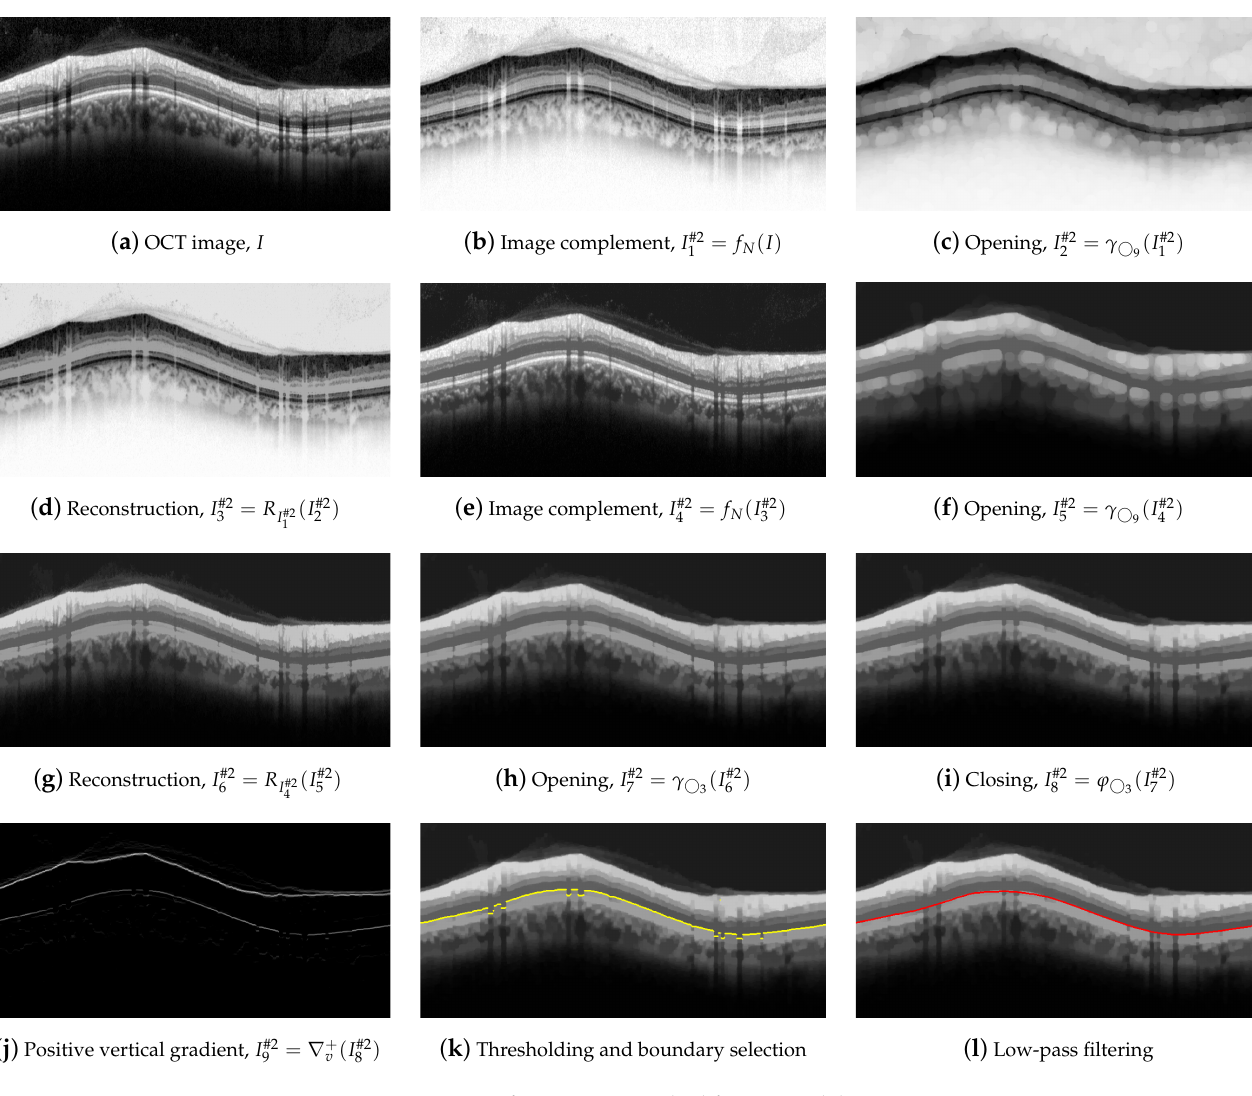
Figure 8. First set of operations applied for #2-AB